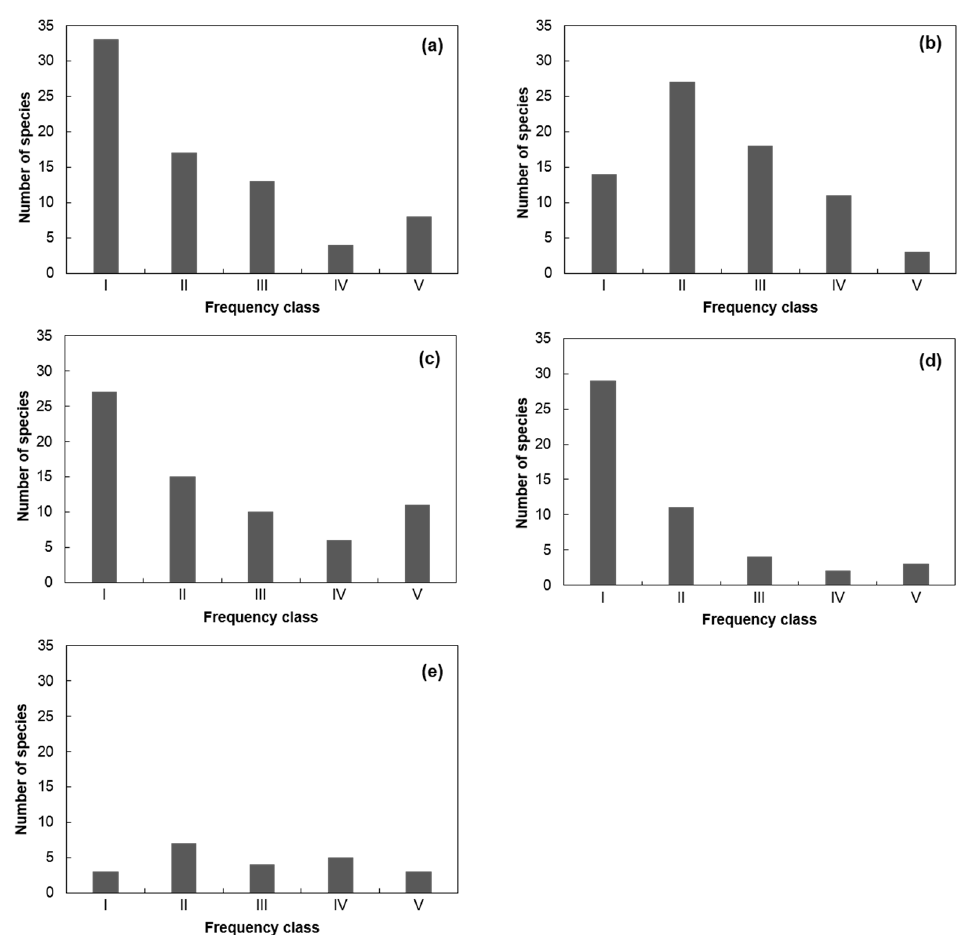
Figure 3. Frequency diagram of forests at ( a ) site 1; ( b ) site 2; ( c ) site 3; ( d ) site 4; and ( e ) site 5. (Frequency class I = Frequency 1–20%, II = 20–40%, III = 40–60%, IV = 60–80% and V =